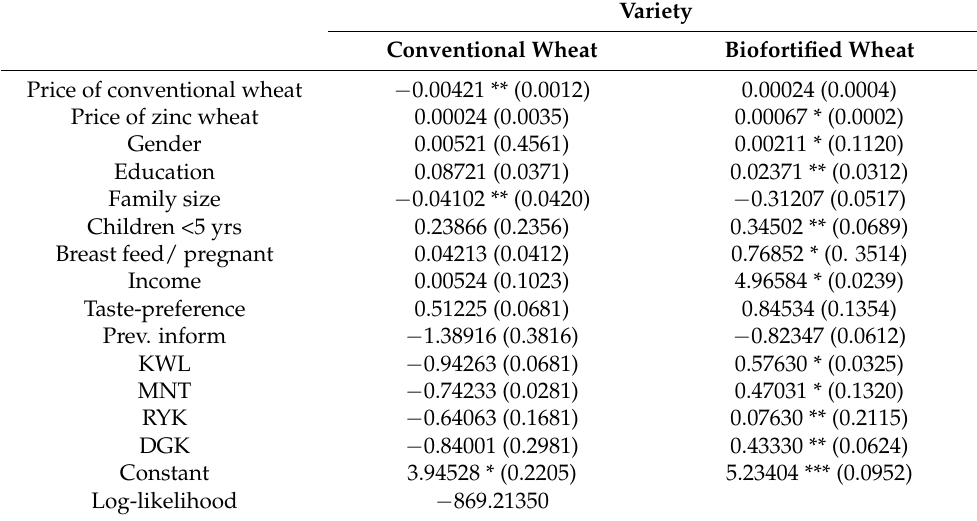
Table 6. A bivariate probit estimation of correlates of willingness to pay – information with